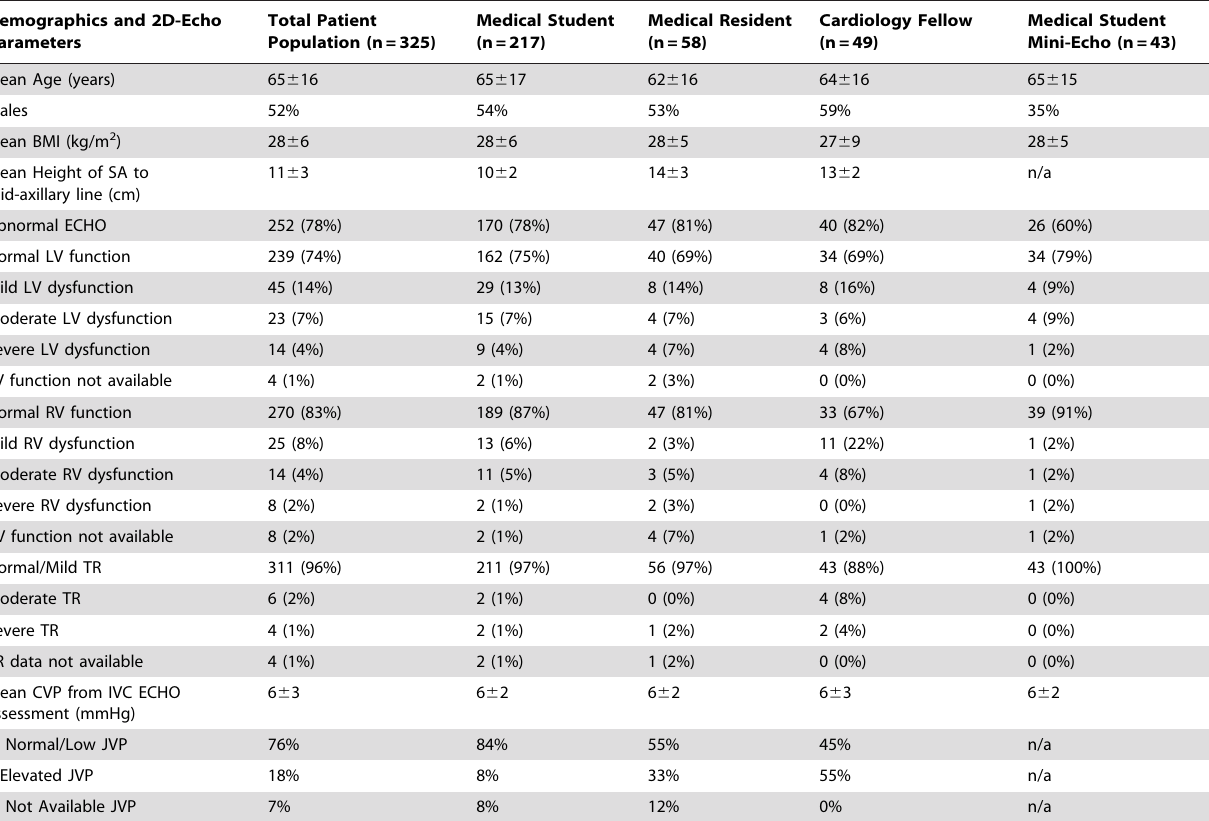
Table 1. Overall patient